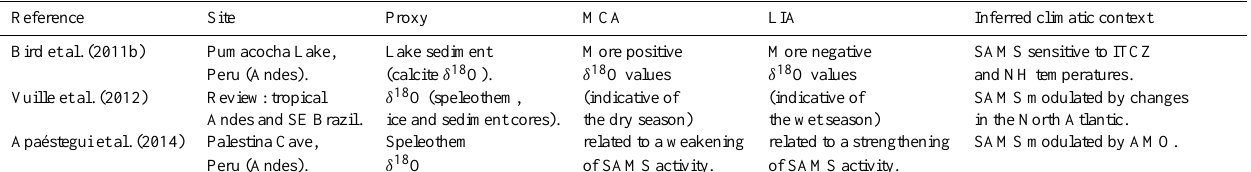
Table 2. High-resolution δ 18 O records related to SAMS changes for the MCA and the LIA.